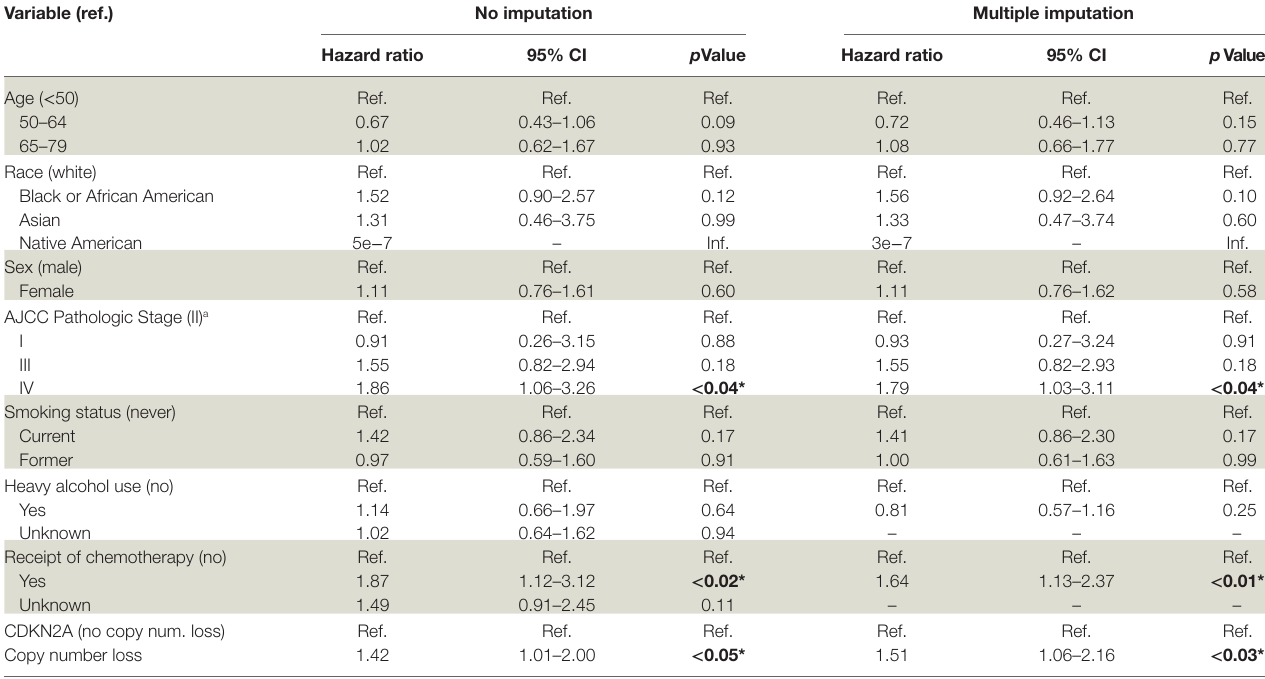
TaBle 3 | Multivariable Cox proportional hazards model of all HPV-negative head and neck squamous cell carcinomas. Variable